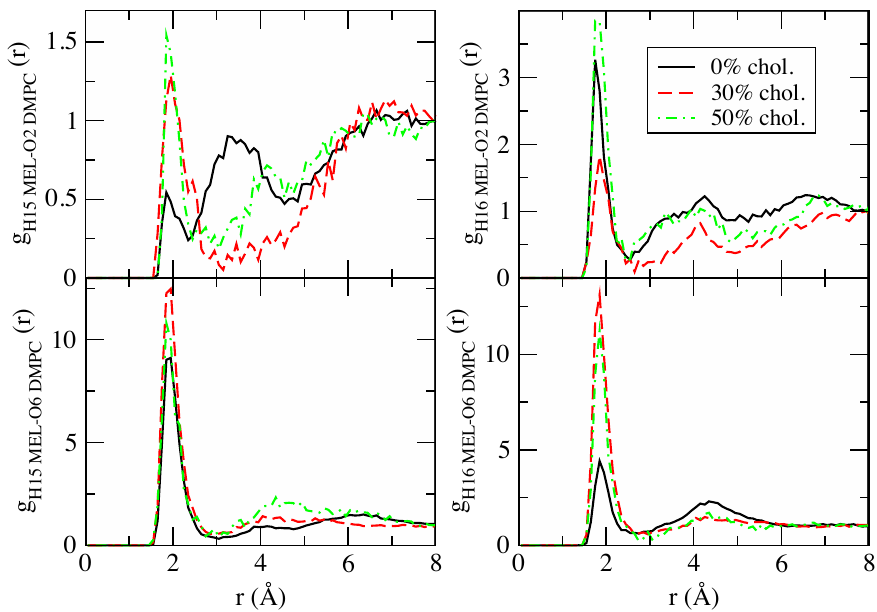
Figure 5. Selected radial distribution functions for hydrogens of MEL (‘H15’ and ‘H16’) with DMPC (‘O2’ (representing ‘O1&O2’) and ‘O6’ (representing ‘O6’ and ‘O8’). The labels as in Figure 1. Data are partially taken from Ref.